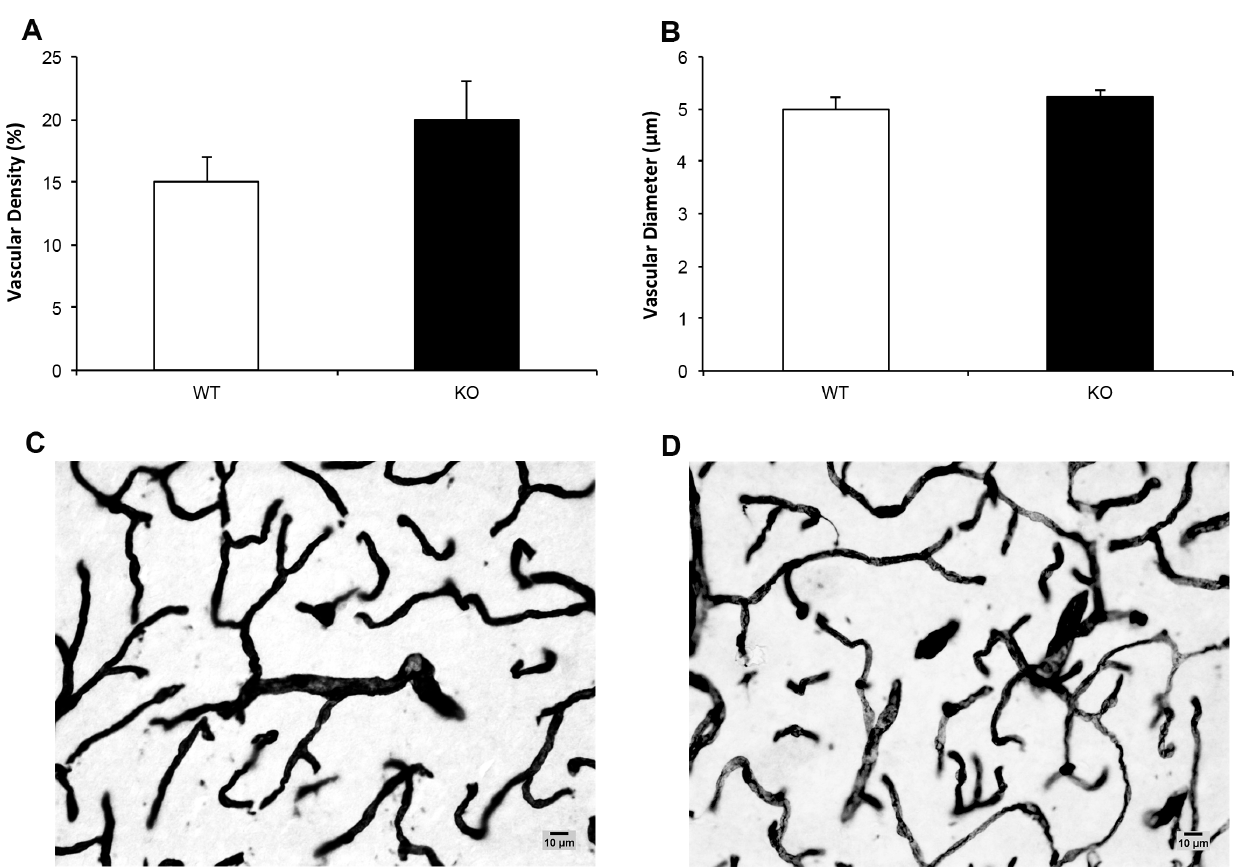
Figure 6. Entorhinal cortical vascular characteristics in PTN KOs and WTs. (a) Vascular density and (b) vascular diameter in entorhinal cortex for KOs (n=9) and WTs (n=10) with alpha collagen IV-stained sections of entorhinal cortical tissue from a (c) WT and (d) KO. Scale bar=10 mm. *p= , 0.05.